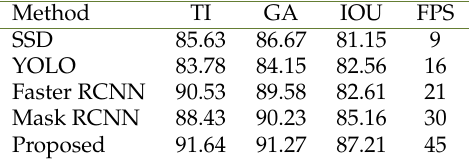
Table 2. Comparison with different